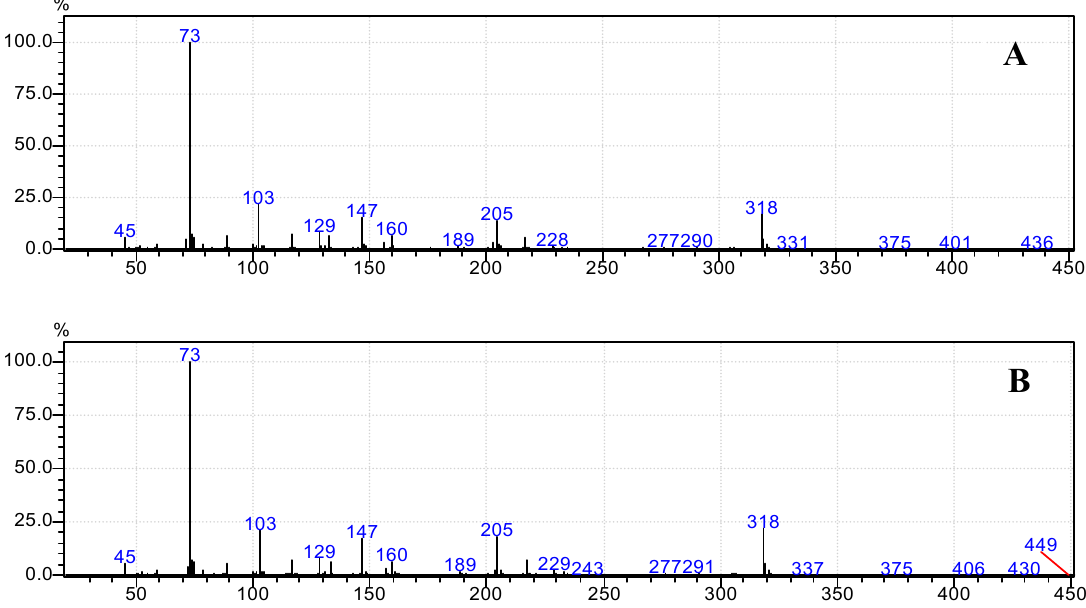
Figure 9. Mass spectrum at a retention time of 3.99 min. ( A ) Standard D -glucose; ( B ) Date juice.